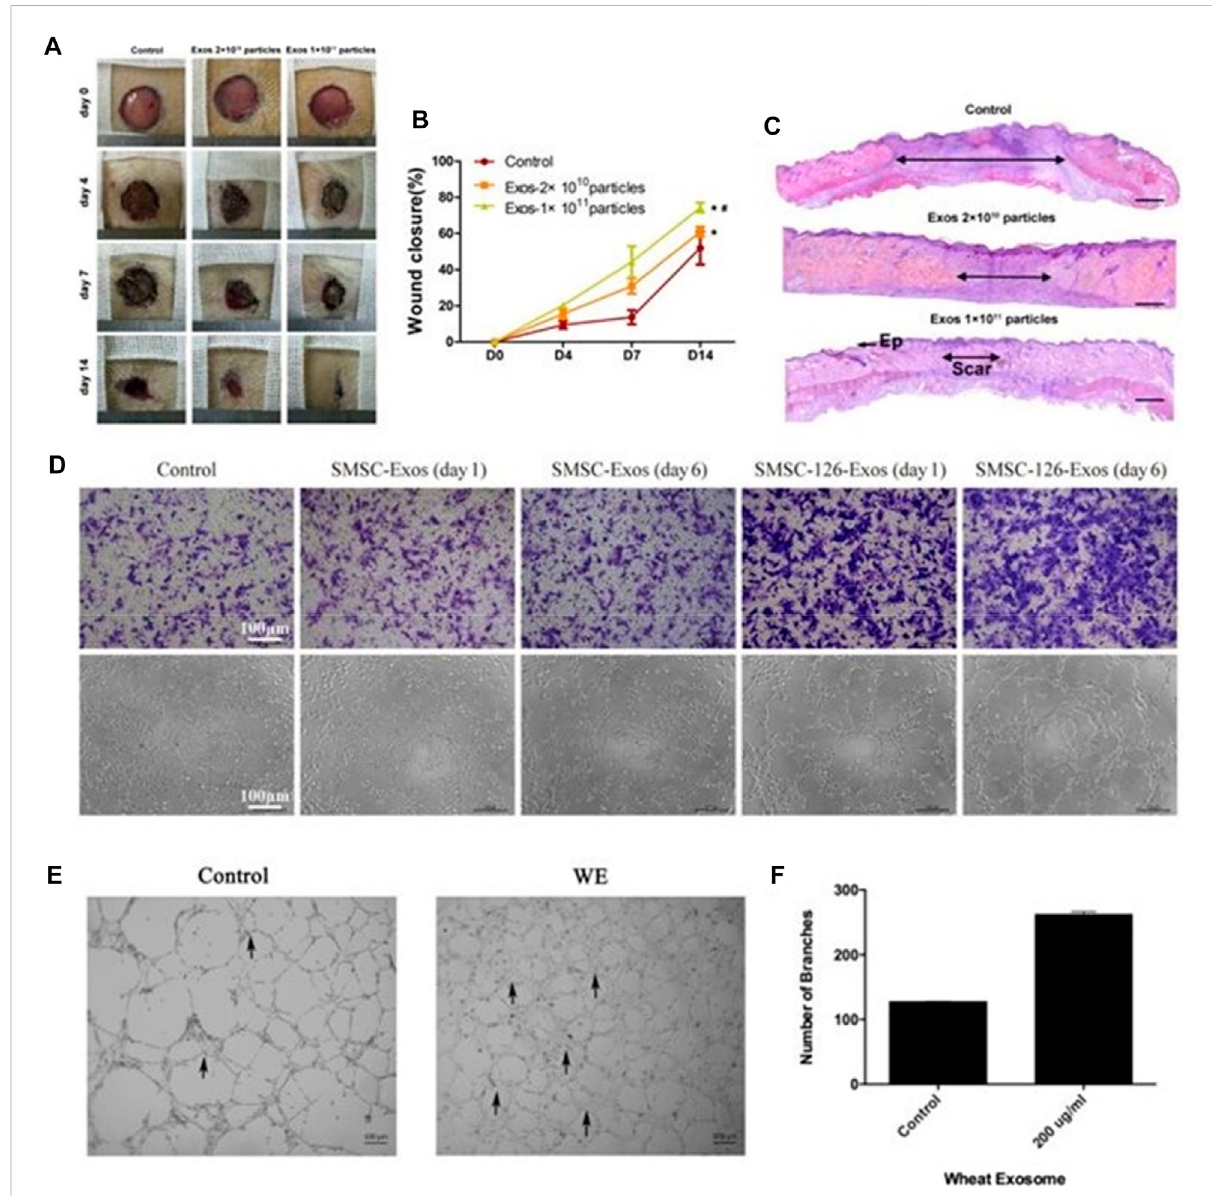
FIGURE 4 Exosomes can accelerate tissue remodeling. (A) General view of wounds treated with PBS or EPC exosomes of different concentrations on the 4th, 7th, and 14th days after trauma. (B) The rate of wound-closure on different days in wounds receiving different treatments. (C) On the 14th day after trauma, the wounds were treated with PBS or EPC exosomes of different concentrations and then stained with H&E (Zhang J. et al., 2016). (D) Representative photographs showing the effect of conditioned medium from days 0 to 6 on the transwell migration and tubule formation of HMEC-1 (Tao et al., 2017). (E, F) Control cells and 200 μ g/ml wheat exosome (WE) – treated cells were incubated (37 ° C, 5% CO 2 ) in DMEM medium supplemented with 10% FBS. Average number of branches formed by both control and treated cells (Sahin et al.,